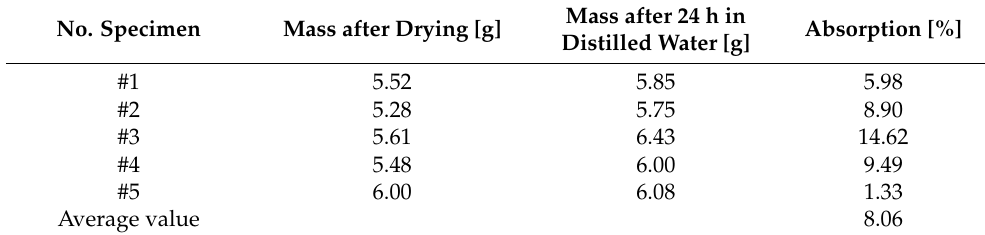
Table 3. Hydraulic oil absorption of Ecoflex 00-30 test